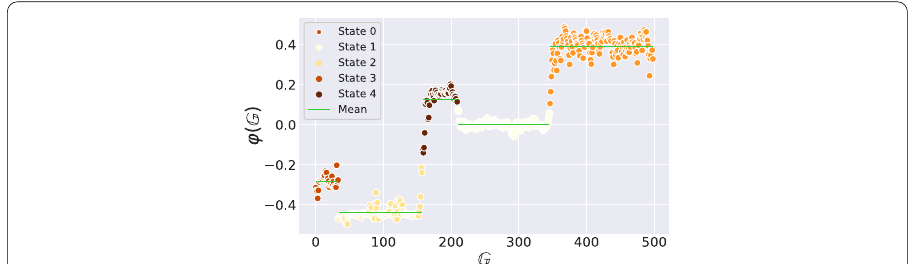
4 c i ϕ i ( G ) and ϕ i ( G ) are i = 0 (cid:31)